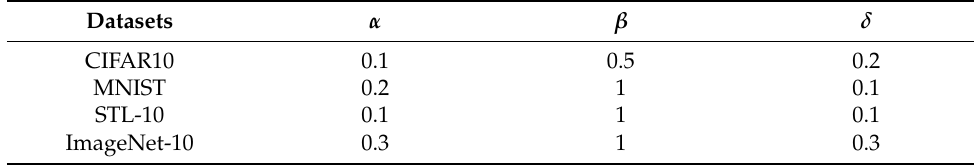
Table 2. Parameter Settings of the Different